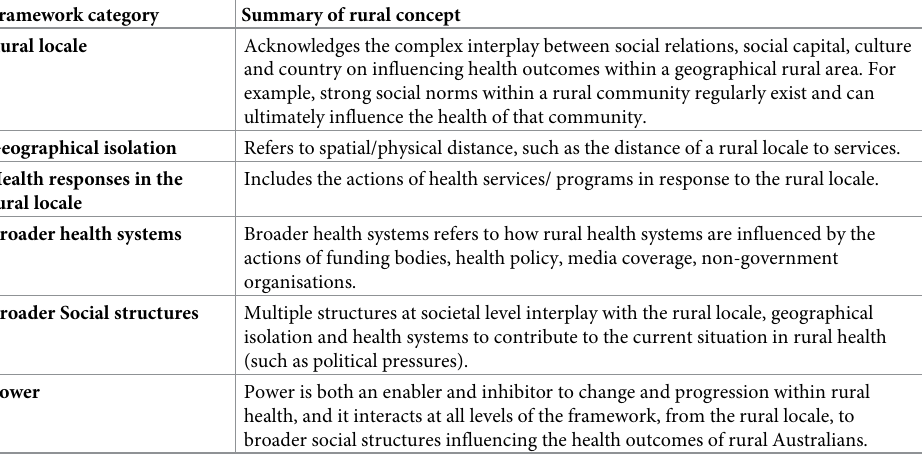
Table 2. Summary of the six categories of the conceptual framework for understanding rural and remote health (Bourke et al., 2012).